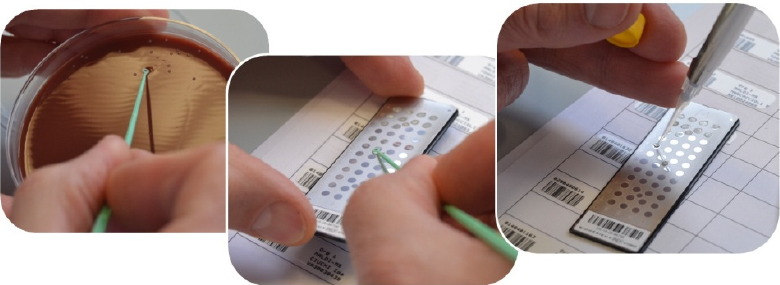
Figure 3. Preparation for colony typing on an MALDI TOF mass spectrometer.